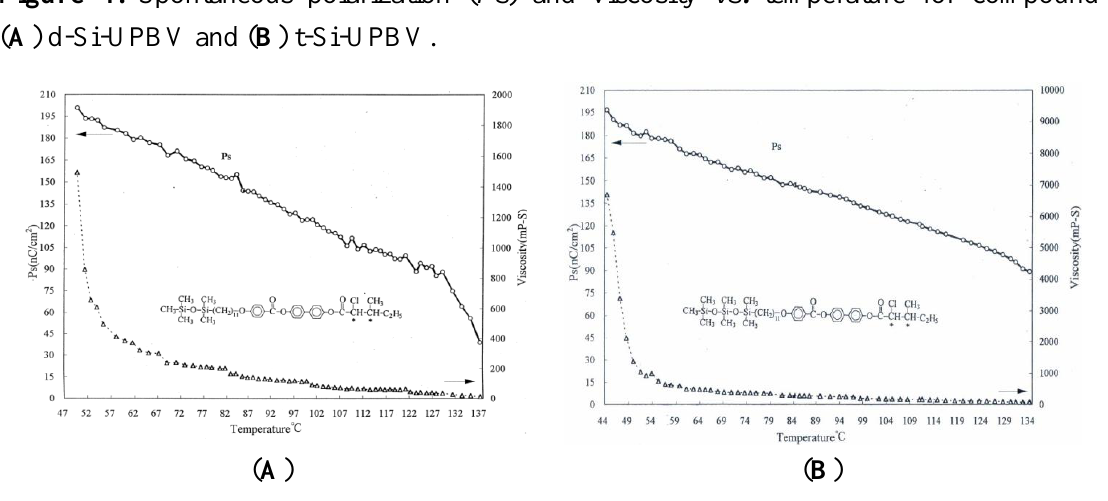
Figure 4. Spontaneous polarization ( Ps ) and viscosity vs. temperature for